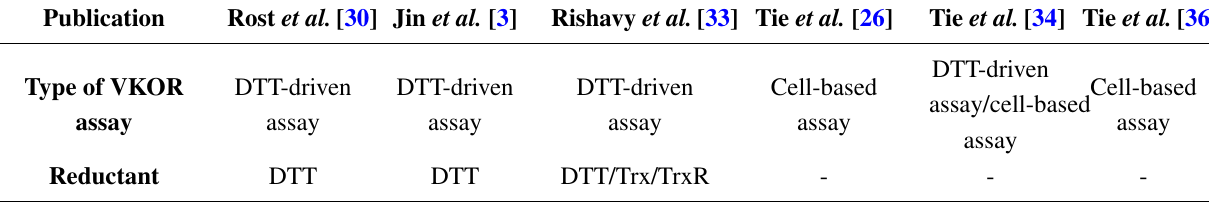
Figure 1. 3TM and 4TM topological models for hVKORC1 (modified from Tie et al. , 2012 [26]). In both models, conserved cysteines (Cys132 and Cys135 of the active center (CXXC motif), green; loop cysteines Cys43 and Cys51, blue) and Arg98_Arg100 of the di-arginine endoplasmic reticulum (ER) retention motif (red) are labeled with colored circles. Amino acid positions for which mutations were reported to be associated with either vitamin K antagonist (VKA) resistance or combined deficiency of vitamin K dependent clotting factors type 2 (VKCFD2) are marked by filled circles (mutations causing VKA resistance, red; VKCFD2 mutation, yellow). ( A ) Shows the putative topology for hVKORC1 as a 3 TM membrane-embedded protein with the loop located in the cytoplasm. The N-terminus is located in the ER lumen, whereas the C-terminus is in the cytoplasm. ( B ) Shows the putative 4TM topology for hVKORC1 with the loop containing the conserved cysteines Cys43 and Cys51 in the ER lumen with both termini located in the cytoplasm. Table 1. Published activities for hVKORC1 conserved cysteines by various functional assays.